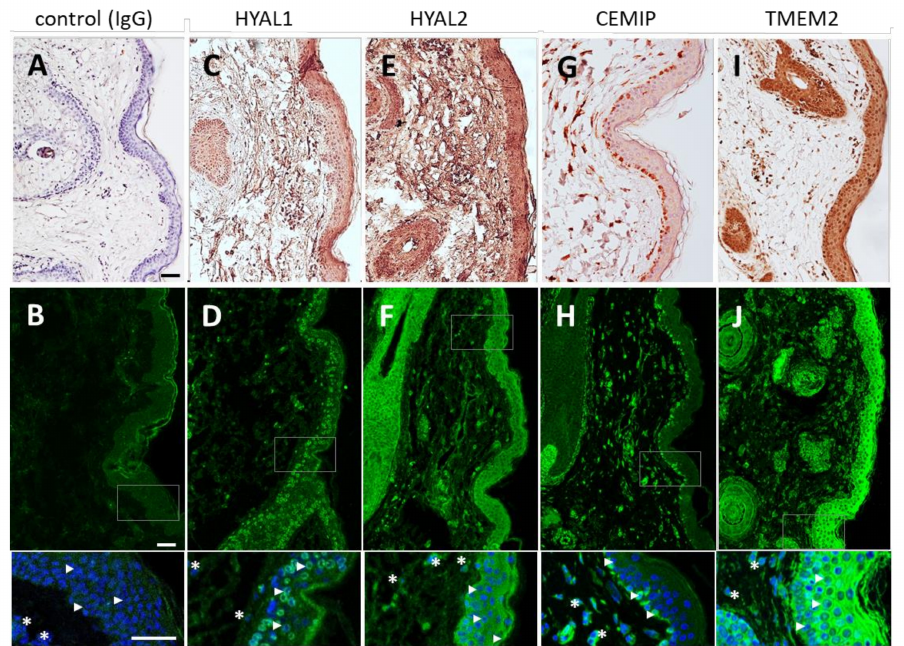
Figure 3. Localization of HYAL1, HYAL2, CEMIP and TMEM2 in the human skin. ( A , B ) Immunohis- tochemical and immunohistofluorescent analysis of IgG, ( C , D ) HYAL1, ( E , F ) HYAL2, ( G , H ) CEMIP and ( I , J ) TMEM2. The insets provide enlarged views of the regions in the gray boxes. The nuclei were stained with Höechst (blue). The asterisks indicate the fibroblasts, and the arrows indicate the ker- atinocytes. The scale bars at the bottom of the figures represent 50 µ m. Abbreviations: hyaluronidase (HYAL), Transmembrane Protein type II (TMEM2), Cell Migration Inducing Hyaluronan Binding Protein